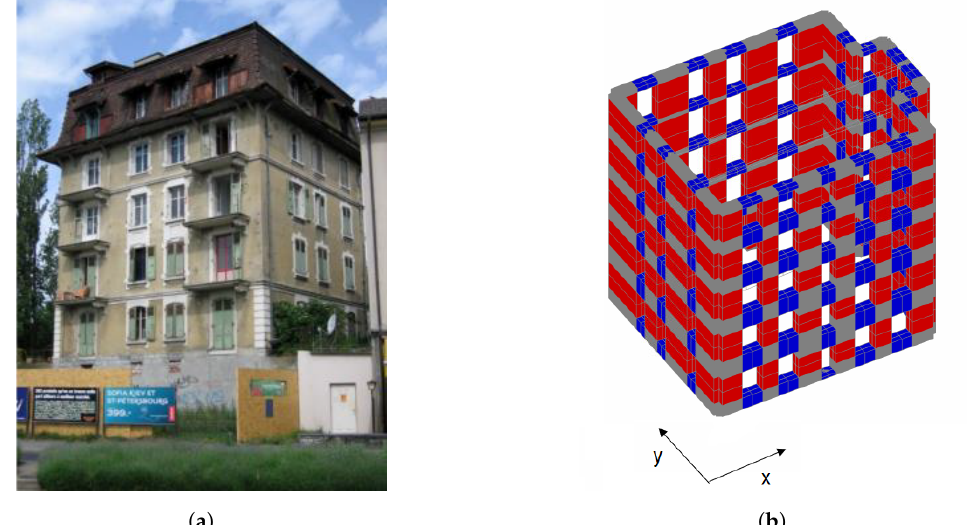
Figure 3. Lausanne Malley. ( a ) Main façade. ( b ) Numerical model with the coordinate